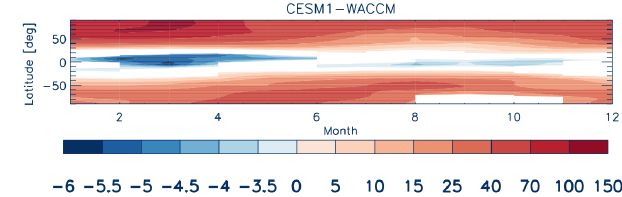
Figure 12. Same as Fig. 11 but for actual CO 2 , in units of 10 − 3 DUppmv 1 (CO 2 ), derived from the REF-C2 and fixed-CO 2 simulations of CESM1-WACCM.